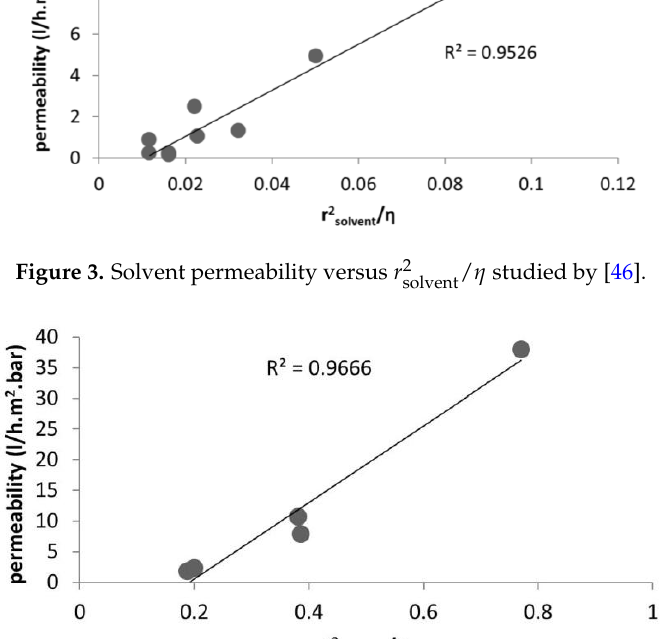
Figure 3. Solvent permeability versus 𝑟 solvent2 /𝜂 studied by [46]. Table 3. Solvent permeability through the ceramic Si–Zr membrane reported by [40].